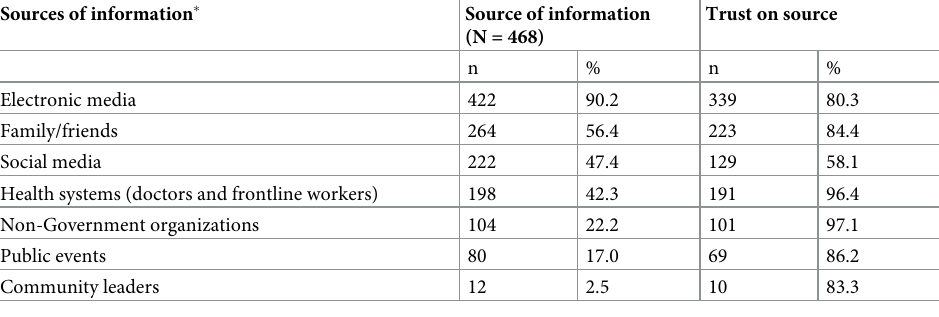
Table 3. Sources of information and their trustworthiness in survey participants among Dharavi residents, Mum- bai, India. Sources of information � Source of information